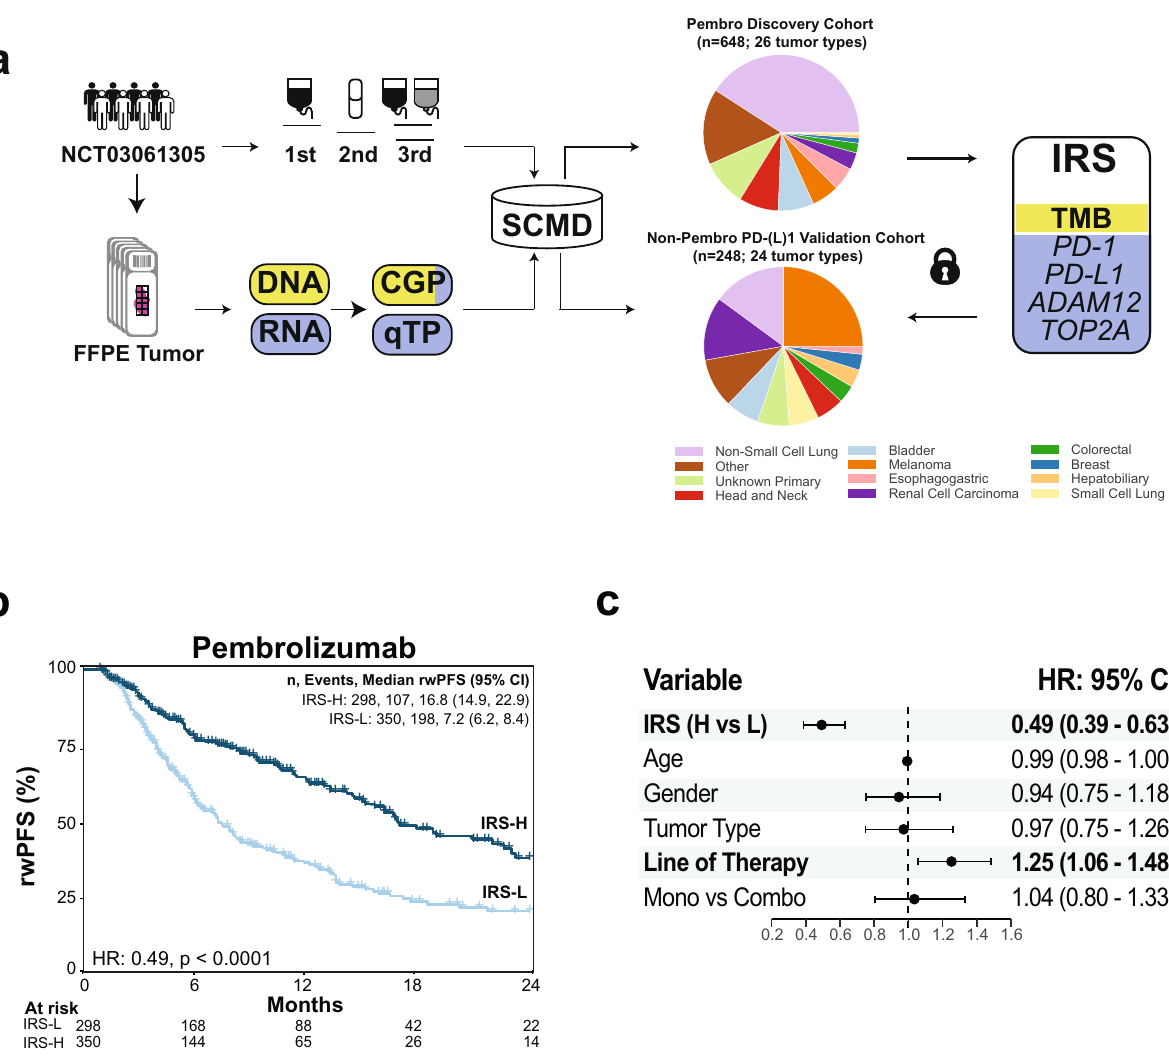
Fig. 1 Development of an integrative immunotherapy response score (IRS) model to stratify PD-(L)1 therapy bene fi t in patients with advanced solid tumors. a Real-world treatment and molecular pro fi ling data from formalin fi xed paraf fi n embedded (FFPE) tumor tissue from patients enrolled in the StrataTrial (NCT03061305) are collected in the Strata Clinical Molecular Database (SCMD). Molecular data from both DNA (yellow) and RNA (blue) include both comprehensive genomic pro fi ling (CGP) with both DNA and RNA components, and in-parallel quantitative transcriptional pro fi ling (qTP) comprised of RNA from analytically and clinically validated tests. To develop an integrative predictor of PD-(L)1 therapy bene fi t, we identi fi ed a cohort of 648 patients (from 26 tumor types) with available molecular information who were treated with a pembrolizumab (pembro; PD-1) containing systemic therapy line of treatment. Lasso-penalized Cox proportional hazards modeling with fi ve-cross validation was used to develop the IRS model for predicting real world progression free survival (rwPFS; by time to next therapy), which includes tumor mutation burden (TMB; from CGP) and expression of PD-1 , PD- L1 , ADAM12 and TOP2A (from qTP). The locked IRS model and threshold to assign patients to IRS-Low [L] or IRS-High [H; increased bene fi t] was then applied to an independent validation cohort of 248 patients (from 24 tumor types) treated with non-pembrolizumab PD-[L]1systemic monotherapy. Pie charts for the development and validation cohorts show tumor type distributions for the 11 most common tumor types and other tumor types. b IRS strati fi es pembrolizumab rwPFS in the development cohort. Pembrolizumab rwPFS in the development cohort strati fi ed by IRS groups is shown by Kaplan Meier analysis with the adjusted hazard ratio (HR) and p value (adjusted by variables shown in ( c ) for IRS-H vs. IRS-L. The number ( n ) of patients, events, and median rwPFS (with 95% con fi dence intervals [CI]) for each group are shown. c IRS is robust to potential confounders in the development cohort. Forest plot of variables included in the adjusted Cox proportional hazards model used to evaluate the ability of IRS to stratify pembrolizumab rwPFS. Adjusted hazard ratios with 95% CIs are shown for each variable with statistically signi fi cant variables bolded. n = 648 patients (from 26 tumor on housekeeping gene selection, correlation of independent PD-1 and PD-L1 amplicons, correlation of tumor-type expression pro fi les for candidate gene expression biomarkers between SCMD predictive of PD-(L)1 therapy bene fi t, we performed Lasso- and The Cancer Genome Atlas (TCGA) pro fi led tumors, and penalized Cox proportional hazards regression with fi ve-fold analytical and clinical validation of the qTP component of the cross-validation in this 648 patient discovery cohort, with the CGP + qTP test (including qRT-PCR and clinical IHC data from highest concordance index obtained using a fi ve-term model that >1,000 total FFPE tumors) is described in the Supplementary included TMB, PD-1, PD-L1, ADAM12 , and TOP2A (Fig. S9), Methods, Supplementary Results, Table S2, and Figs. S7 and S8. with increasing TMB, PD-1 and PD-L1 associated with longer